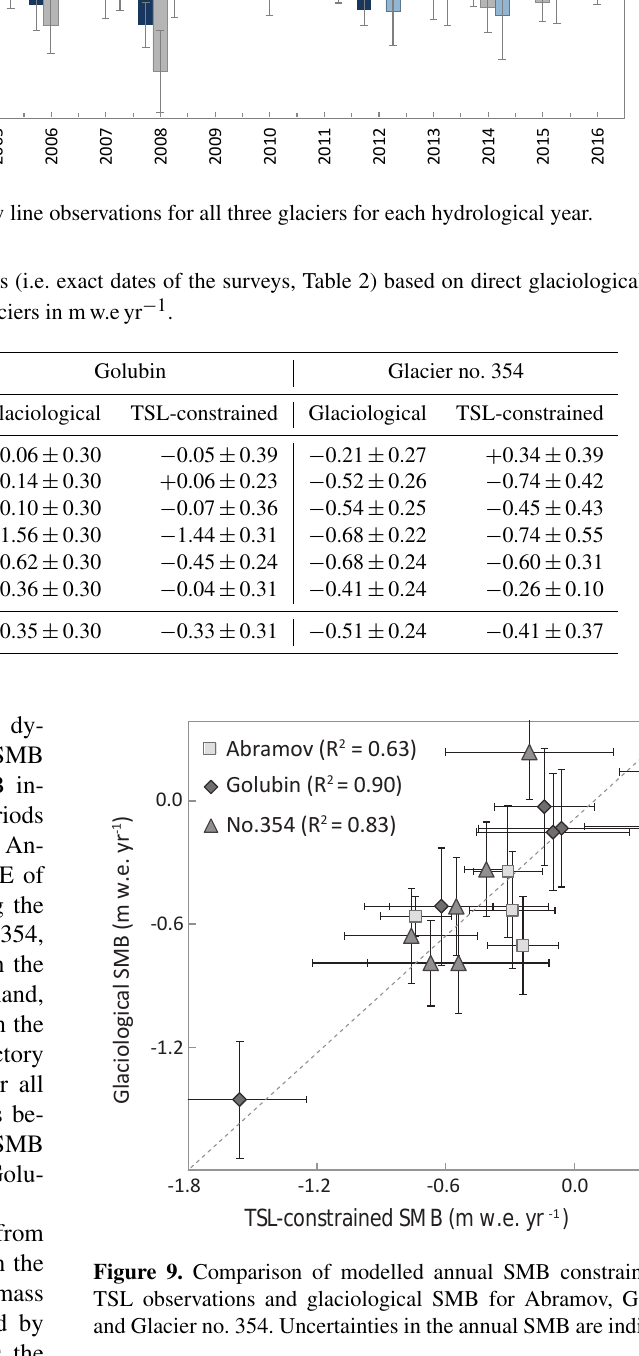
the same period (Table 8 and Fig. 11). Comparison of dig- ital elevation models indicated that Glacier no. 354 had